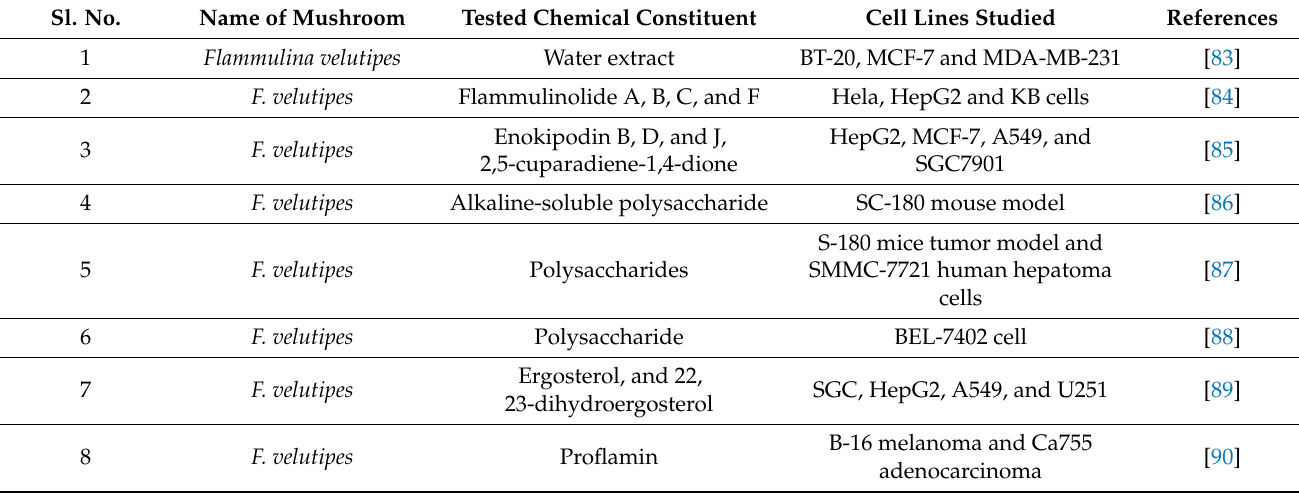
Table 3. Mushrooms have anticancer